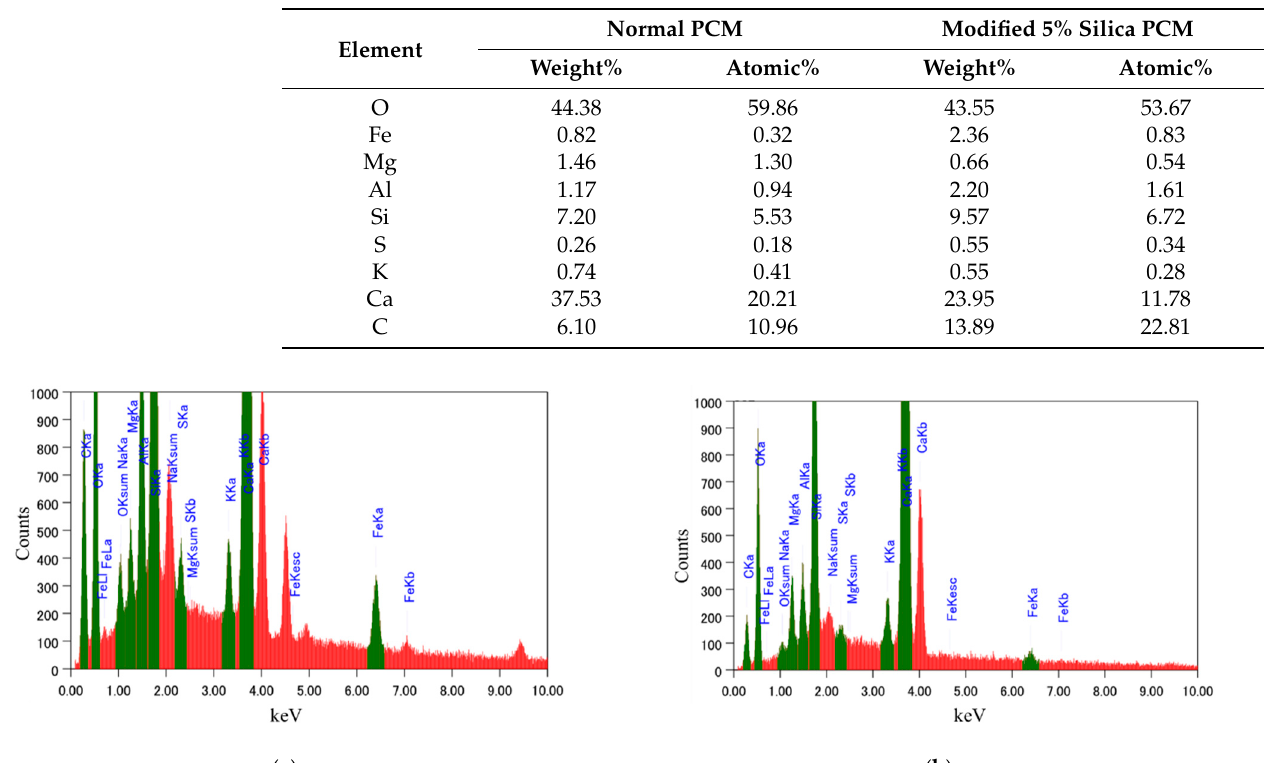
Table 6. EDS elemental quantification results.